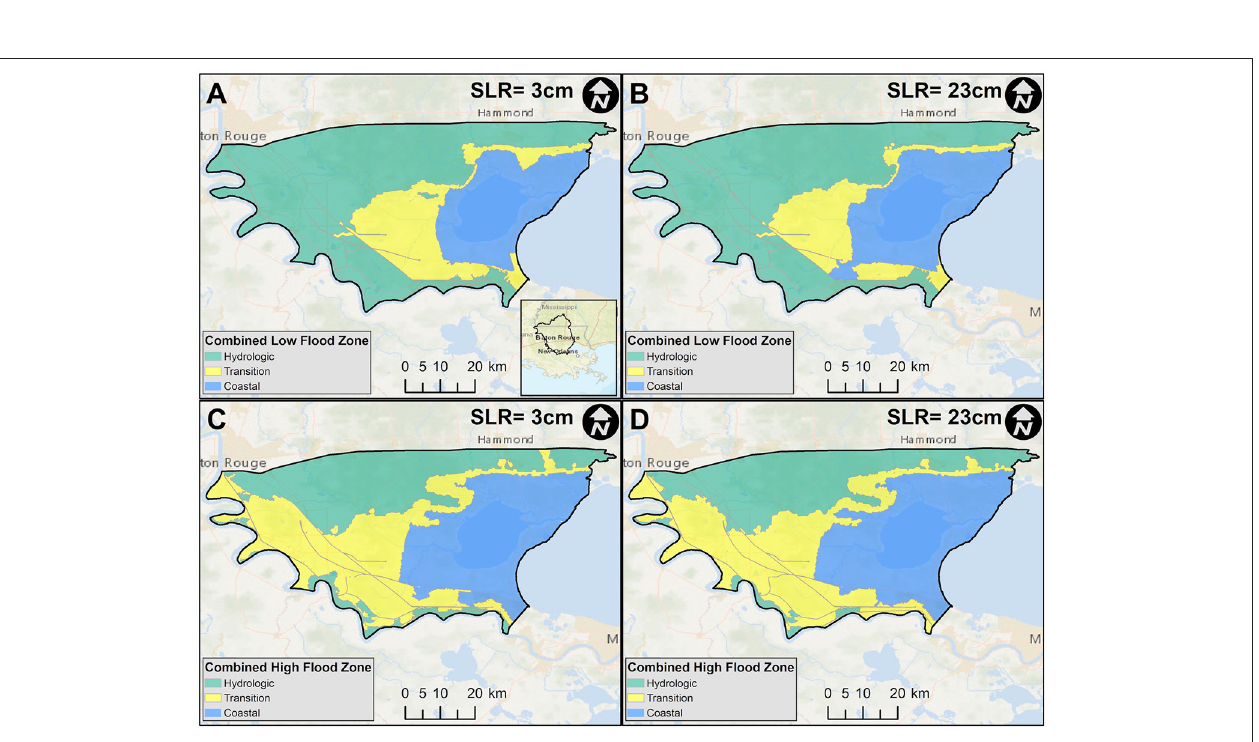
Frontiers in Climate |